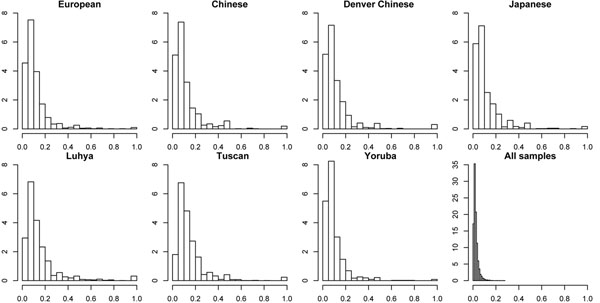
Distribution of the correlation r2 between rare alleles and common SNPs in the subpopulations and overall. The correlation is between the common SNPs and the number of rare alleles present in five random rare SNPs within a 1-Mb region. X-axes are the correlation r2, y-axes are the probability densities.